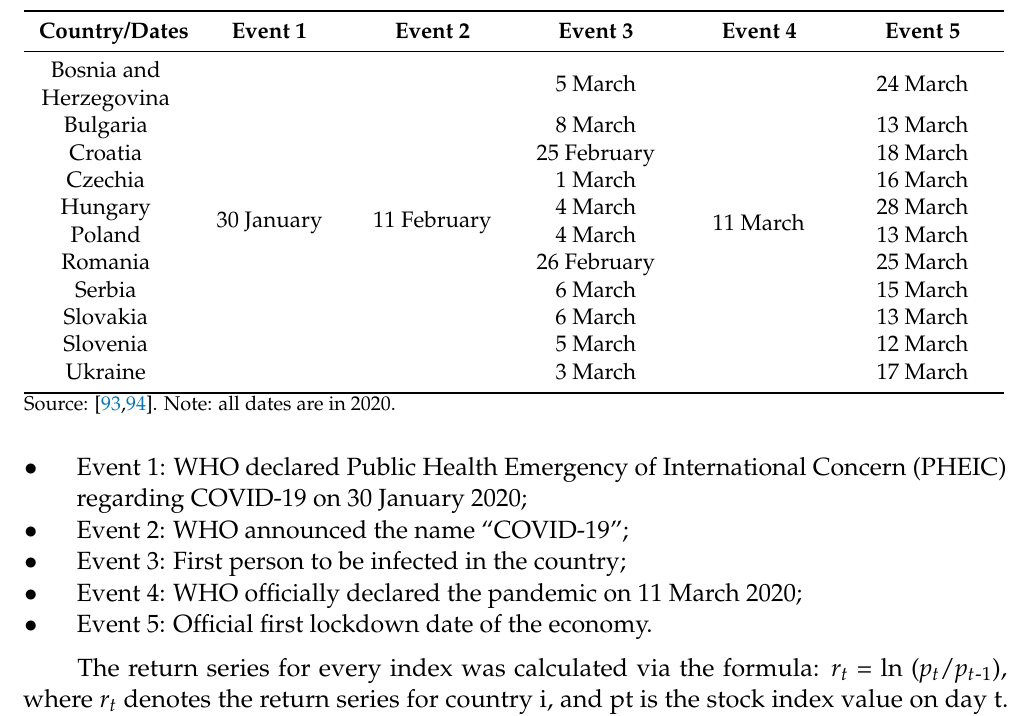
Table 2. Main event dates to be